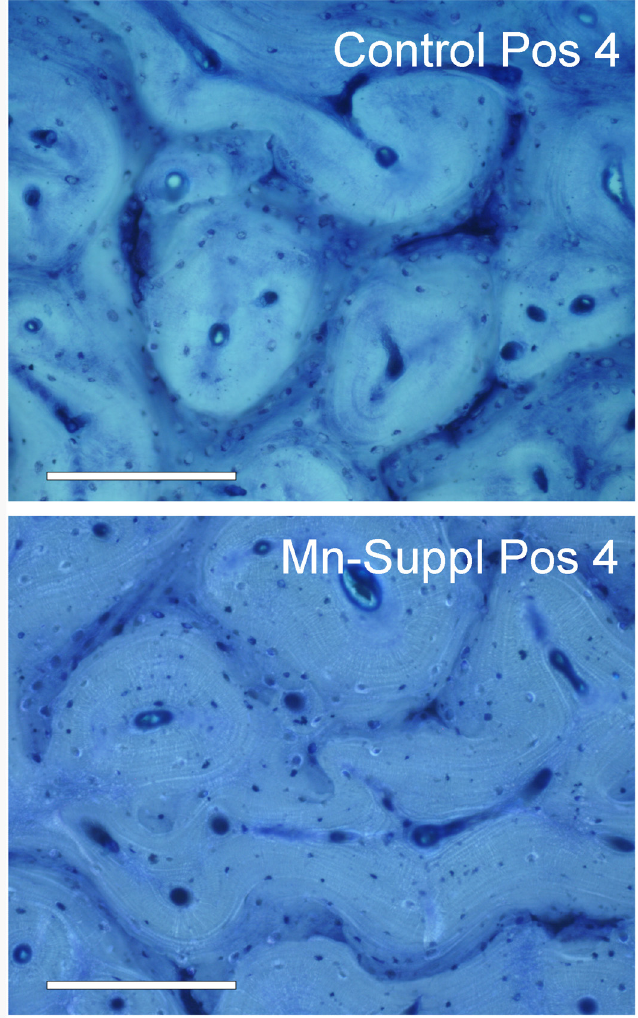
Fig 1. Histology of cortical bone in antlers from control and Mn-supplemented adult groups. Note that primary osteons are complete in both cases. Mn-supplemented osteons looks normal, osteomalacic seams — an indicator of Mn toxicity — are not observed (Bar scale = 200 μ